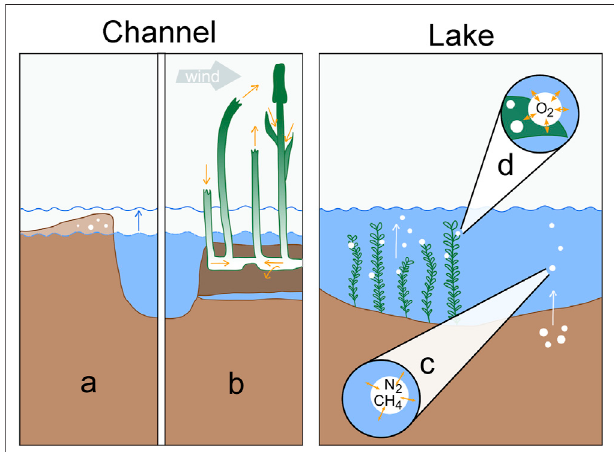
FIGURE 7 | Processes determining dissolved gas concentrations in channels(left)andshallowlakes(right): (A) Excessairformationviawatertable fl uctuation in riverbanks. (B) Convective sediment aeration by Phragmites australis in permanently inundated reed areas. The two left culms illustrate venturi-induced convection, the right two culms represent humidity- induced convection. (C) Gas stripping by CH 4 bubbles rising from anoxic sediments. (D) Gas stripping by O 2 bubbles forming on macrophyte leaves during intensive photosynthesis.